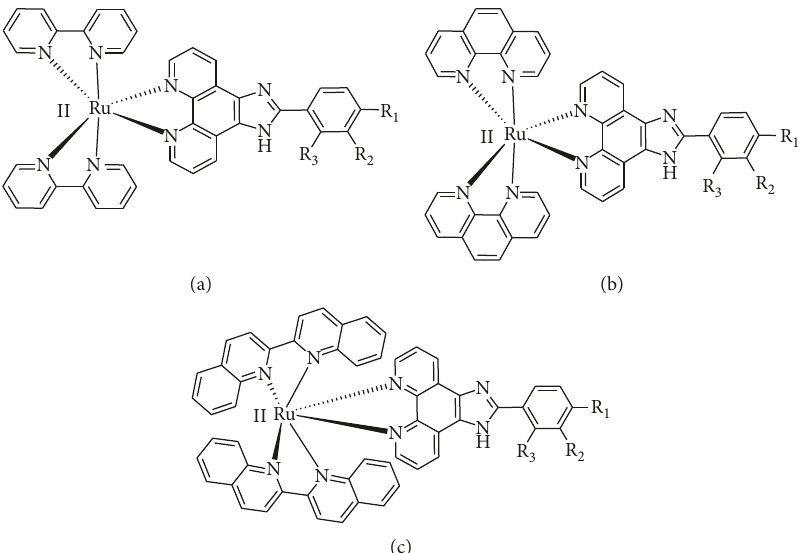
2+ , (b) [Ru(phen) 2+ , and (c) [Ru(biq) 2+ , where L is FPIP, NPIP, BPIP, and CPIP with 2 L] 2 L] 2 L]